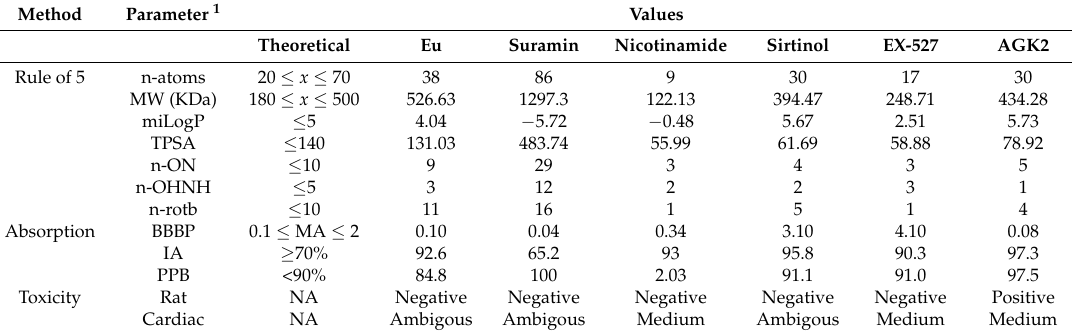
In silico drug-likeness parameters calculated for reference sirtuin inhibitors (SIRTi) and